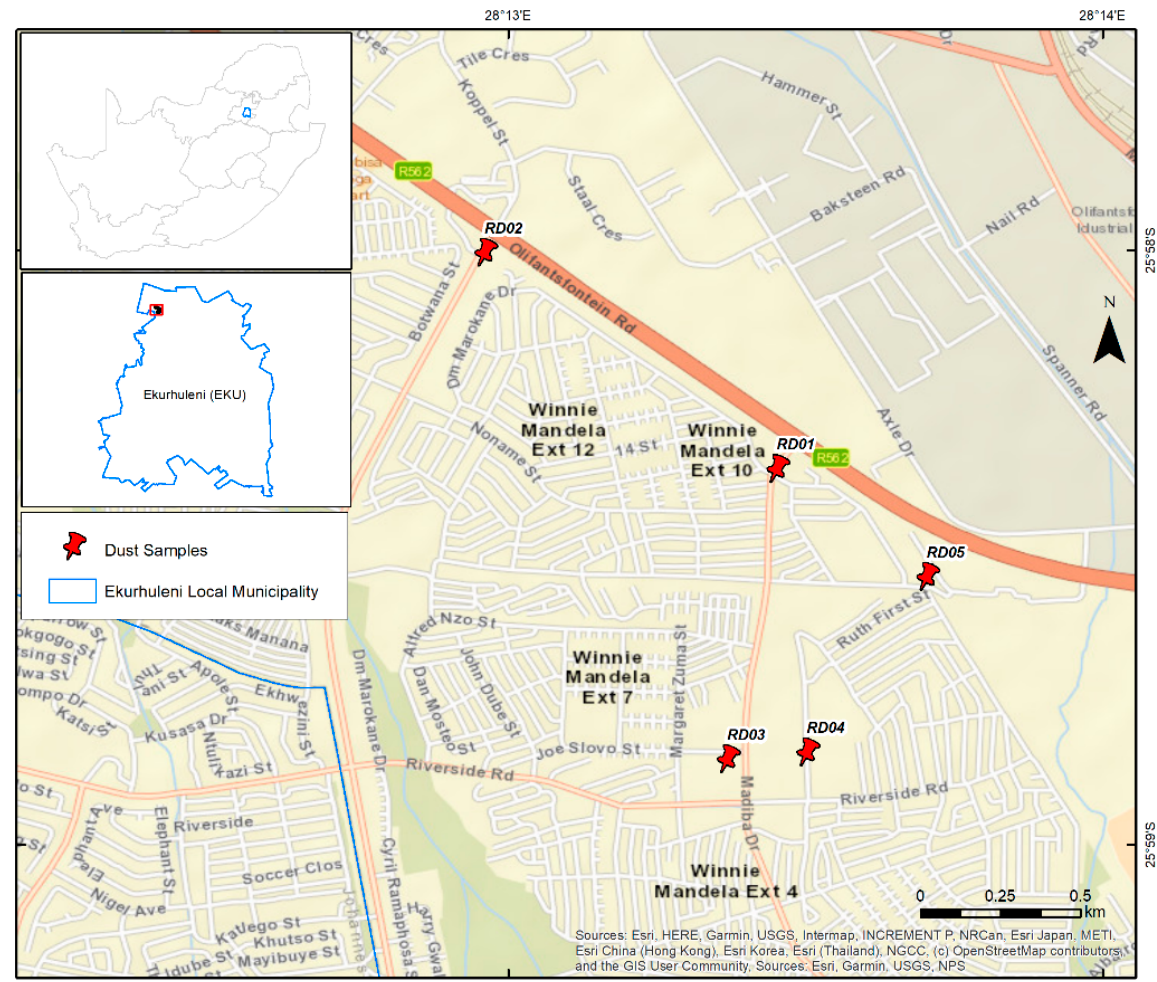
Figure 1. Study area and the location of the sampling site.